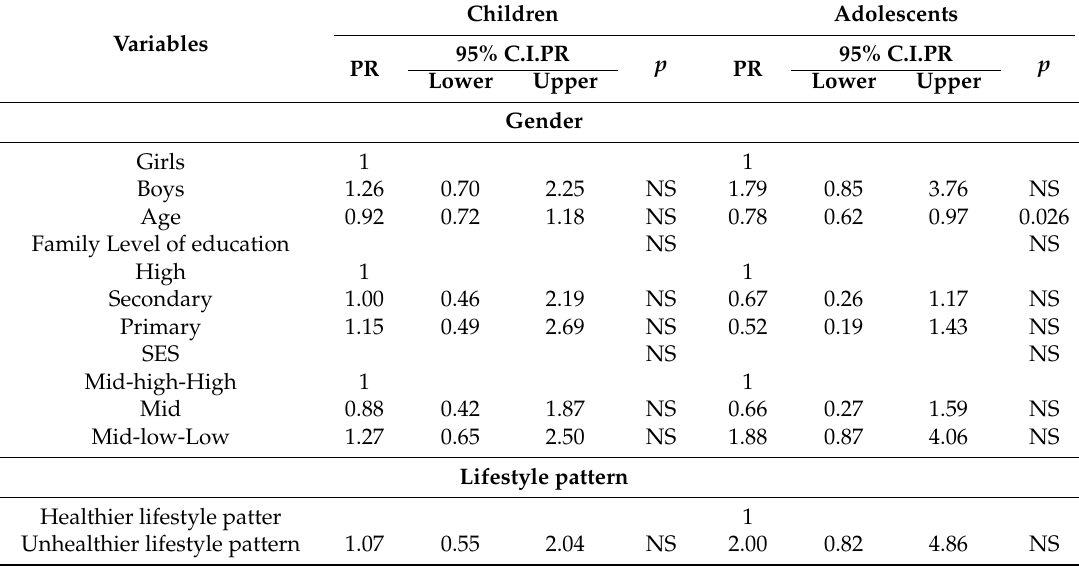
Table 4. Prevalence ratio (PR) of overweight/obesity in children and adolescents, according to gender, age, family level of education, socioeconomic level and lifestyle pattern a in children and in